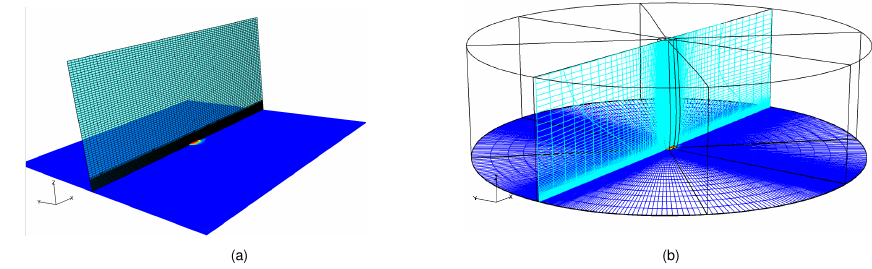
Figure 7. Bolund Hill: volume grid generated with (a) SnappyHexMesh and (b)